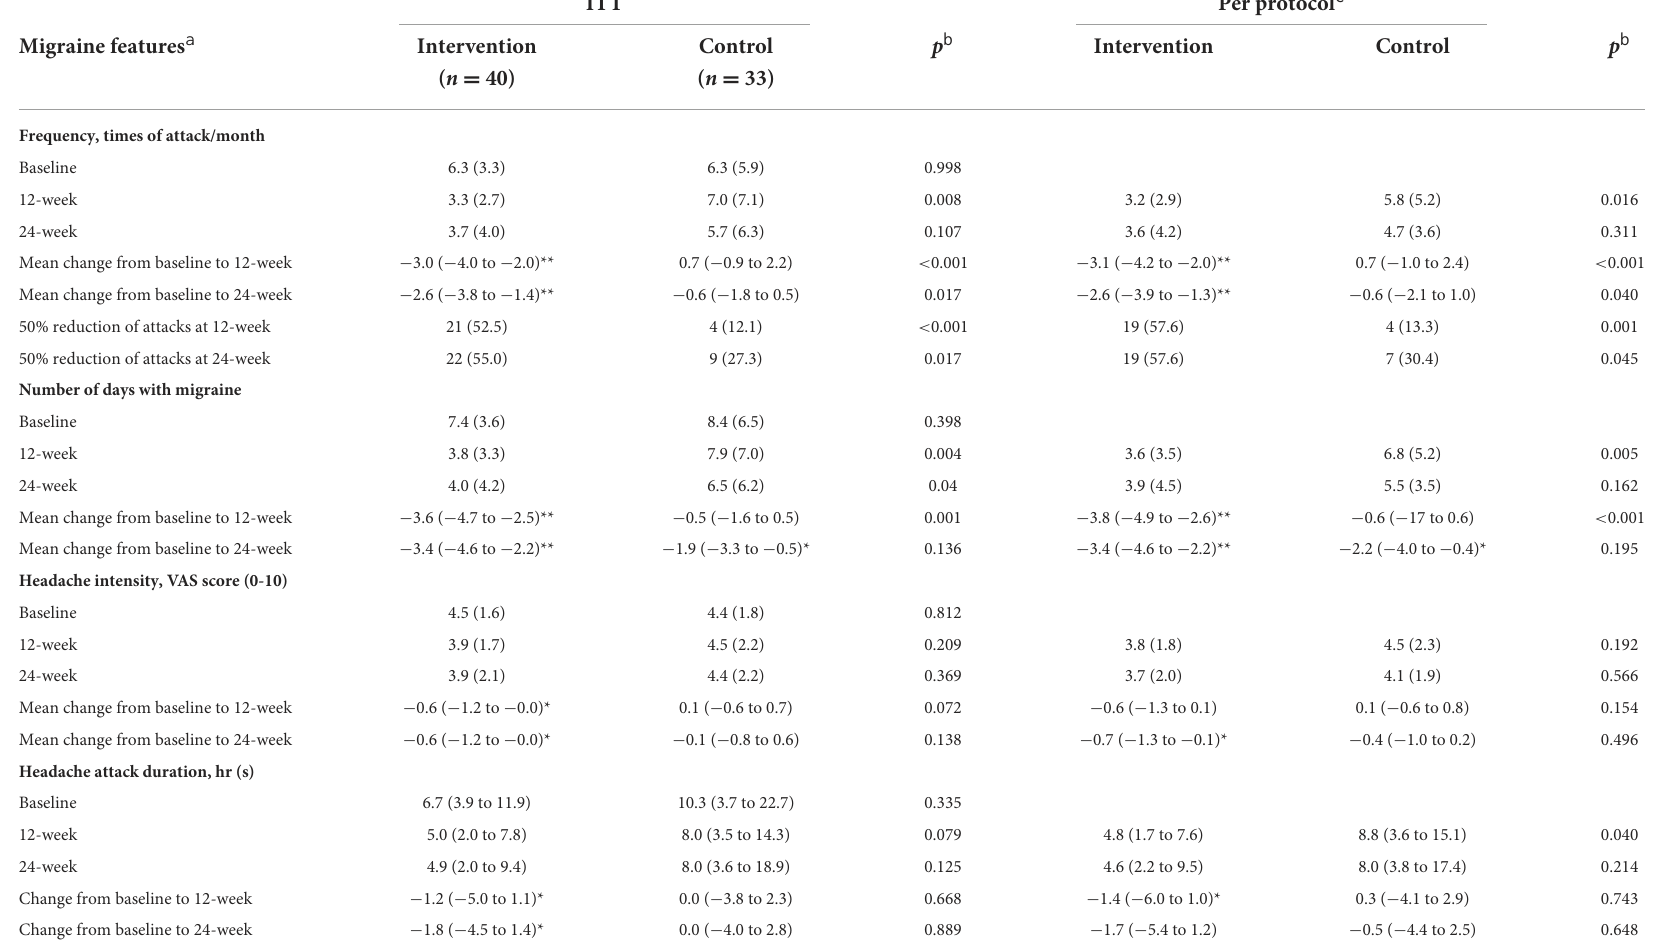
TABLE 2 Changes of migraine features from baseline to 12-week and